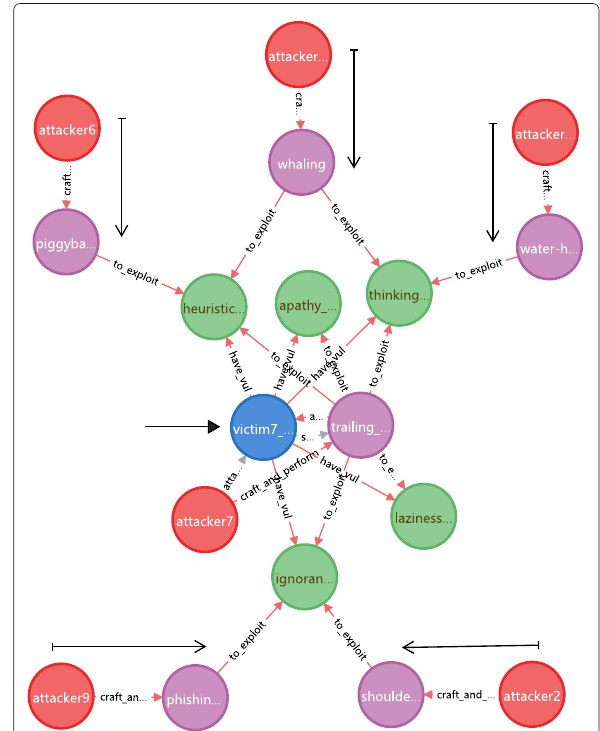
Fig. 23 For specific victim, find additional threats beyond the given scenario Figure 23 shows this application where victim7